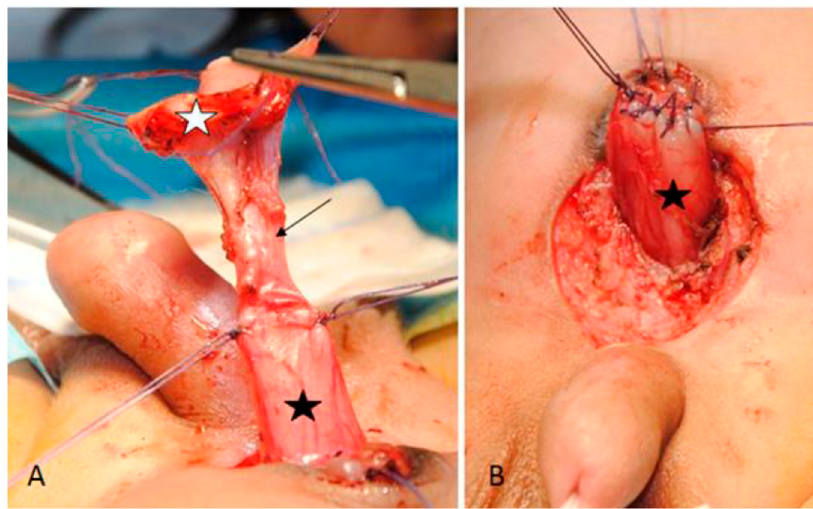
Figure 3. Bladder (black star) exstrophic plate (white star) and their connection (arrow) before ( A ) and after repair ( B ).